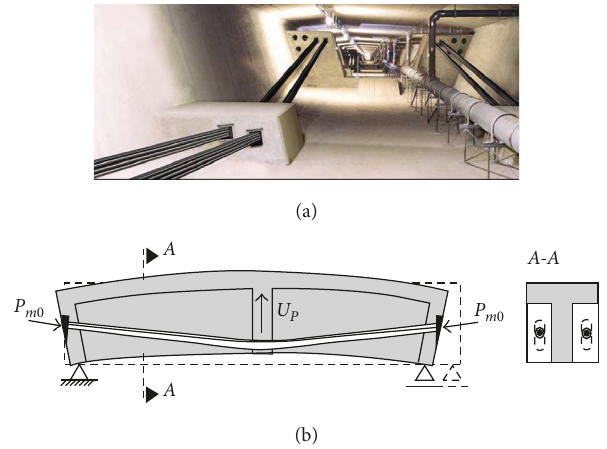
Figure 1: (a) Externally posttensioned: inside of box girder cross section. (b) Externally posttensioned beam: girder outside web.